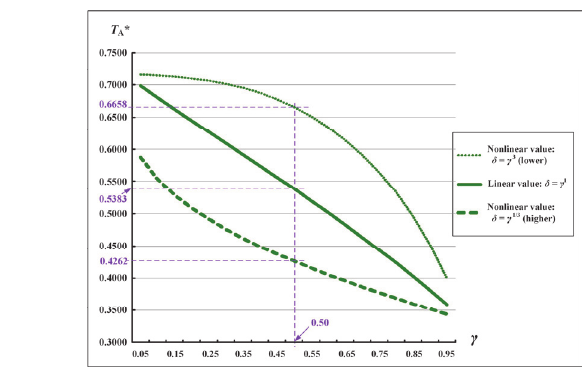
Fig. 10. The impact of different relationships between  and  on T A *